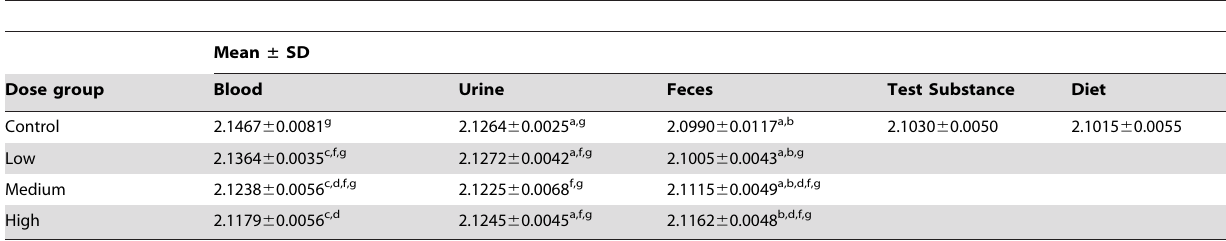
Table 4. Statistical significance of differences in 208 Pb/ 206 Pb for test substance, diet, blood, urine, and feces in different dose groups (n= 6) of respiratory lead